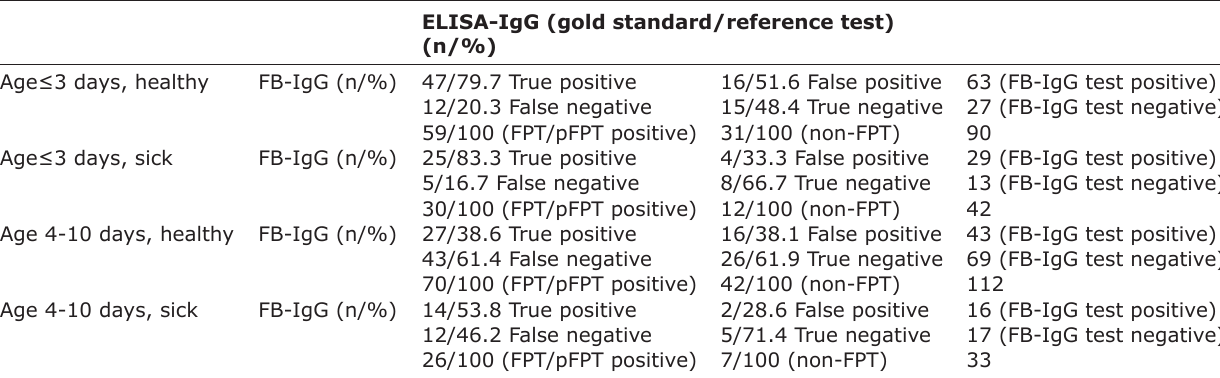
serum IgG concentration≥10 mg/mL=Sufficient supply of colostral antibodies, n=Absolute frequency, %=Relative frequency. IgG=Immunoglobulin G, ELISA=Enzyme-linked immunosorbent assay